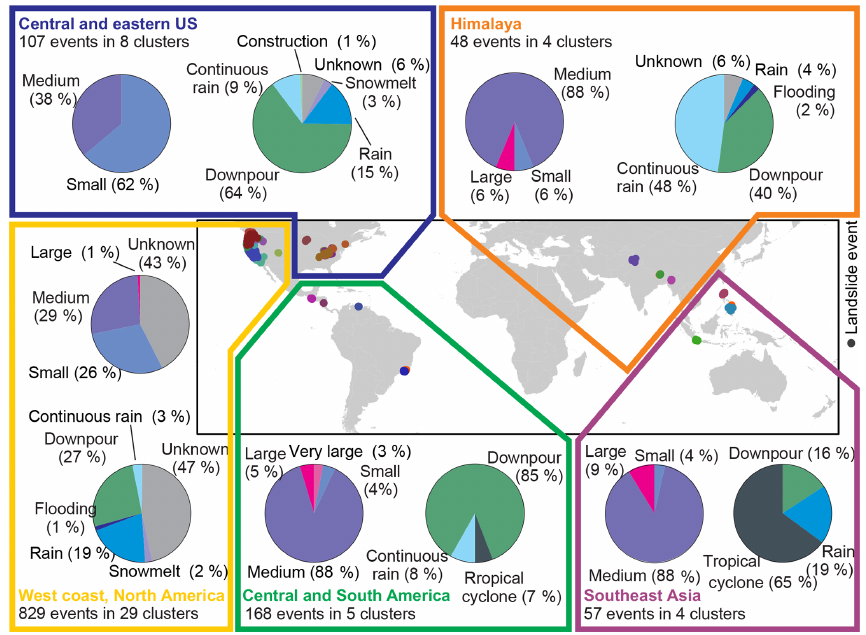
Figure 4. Location of all landslide events within clusters ≥ 10 events (different colors indicate different clusters). Overall, clusters in five distinct regions could be identified in the GLC (see Table S1 in the Supplement for more detail). Size and trigger (GLC categorization) of the associated landslide events are also shown (also see Tables S2 and S3). Table 1. Regional statistics for all landslide clusters (LCs) with at least 10 landslide events (LEs). Region No. of LC No. of LE LE Average LEs Average Percentage per duration day area of of LE in a LC of LCs LCs (km 2 ) LC ≥ 10LE Global 50 1209 24.2 7 3.5 35441 13 West coast of North America 29 829 28.6 9 3.3 52970 31 Central and eastern US 8 107 13.4 6 2.4 23357 12 South and Central America 5 168 33.6 3 11.2 1320 18 Himalayas 4 48 12.0 5 2.3 5476 3 Southeast Asia 4 57 14.3 5 3.2 5143